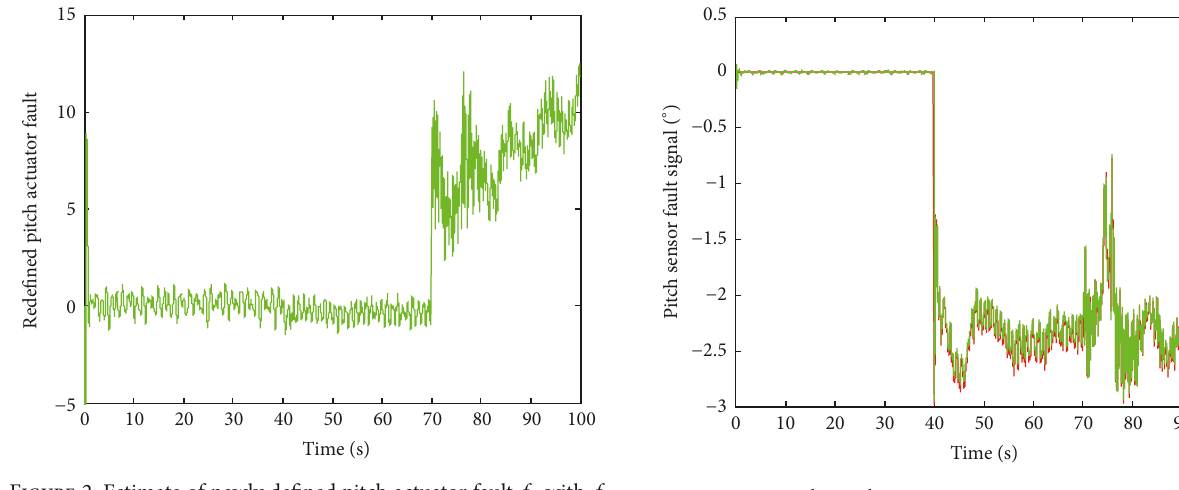
Figure 2: Estimate of newly defined pitch actuator fault 𝑓 𝑎 with 𝑓 𝑠 = − 0.2.